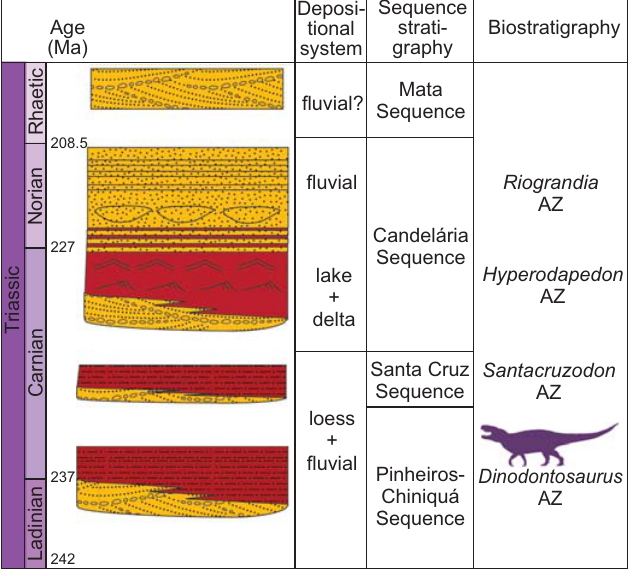
vation 34; Huene 1942; Krebs 1976): splenial, anterior portion of the surangular, anterior portion of the angular, prearticular, right partial premaxilla, fragmentary dentary, three incomplete cervical vertebrae, fragmentary ribs, one sacral vertebrae, two sacral ribs, five anterior caudal vertebrae with chevron bones, 14 middle and posterior caudal vertebrae, right and left scapulacoracoid, interclavicle and clavicle, distal left humerus, right proximal and distal humerus, distal radius,